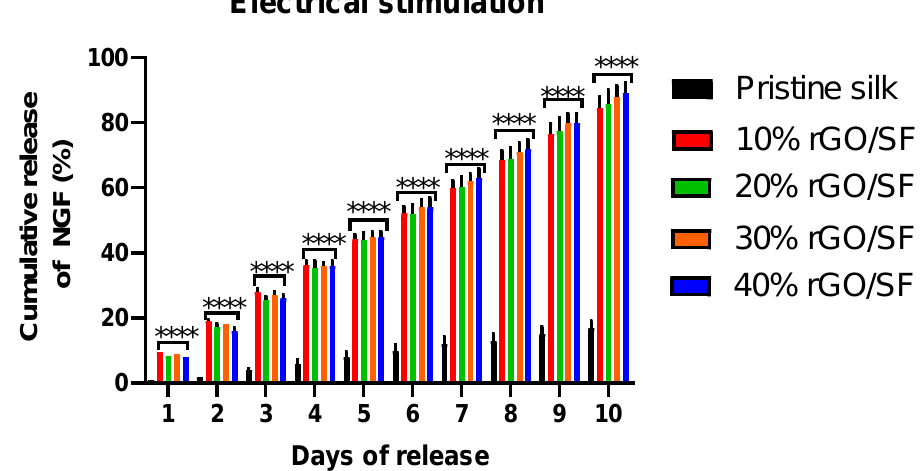
Figure 3. Electrically enhanced delivery of NGF-β from electroconductive/active silk-based scaffolds. Cumulative release percentage from the films ( n = 3 per type) with electrical stimulation. The differences between the experimental groups were analyzed by two-way ANOVA using Tukey’s post hoc test for multiple comparison ( p -value with respect to pristine silk). **** p < 0.0001.